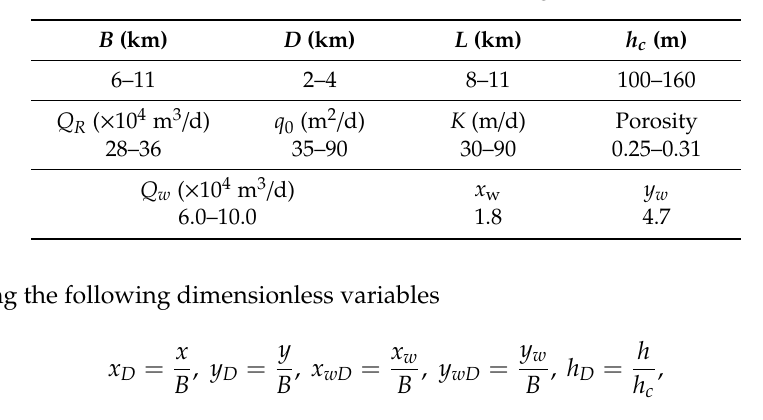
Table 1. Characteristics of the site in Figure